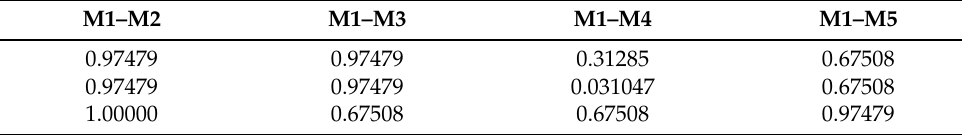
Table A1. p -values of the Kolmogorov–Smirnov test Assumption 1